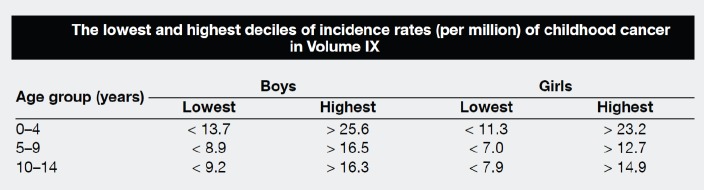
The lowest and highest deciles of incidence rates (per million) of childhood cancer in Vol IX.